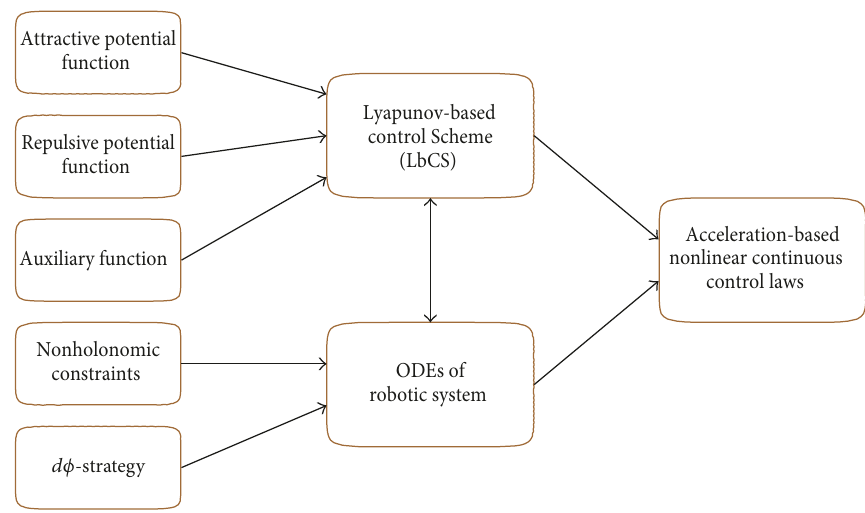
Figure 2: The design process of the nonlinear acceleration-based continuous control